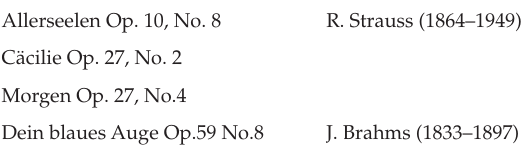
(Figure 1). Heinrich Hart’s text overflows with